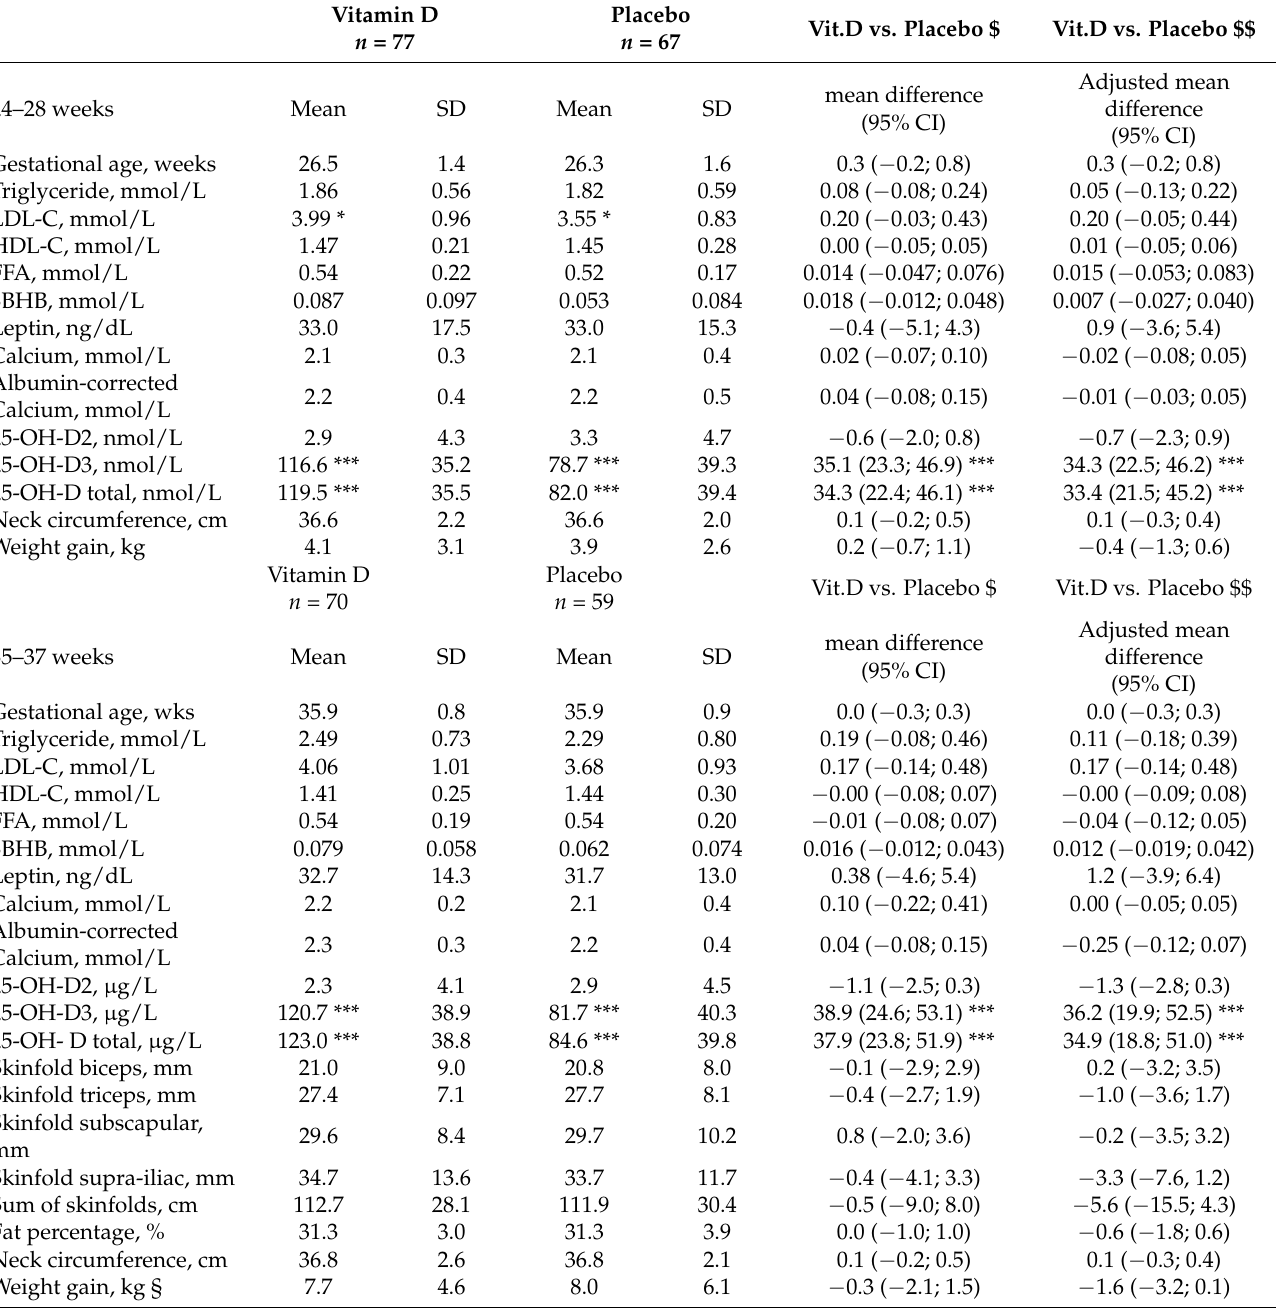
Table 2. Primary and secondary outcomes in the two intervention groups and intervention effects